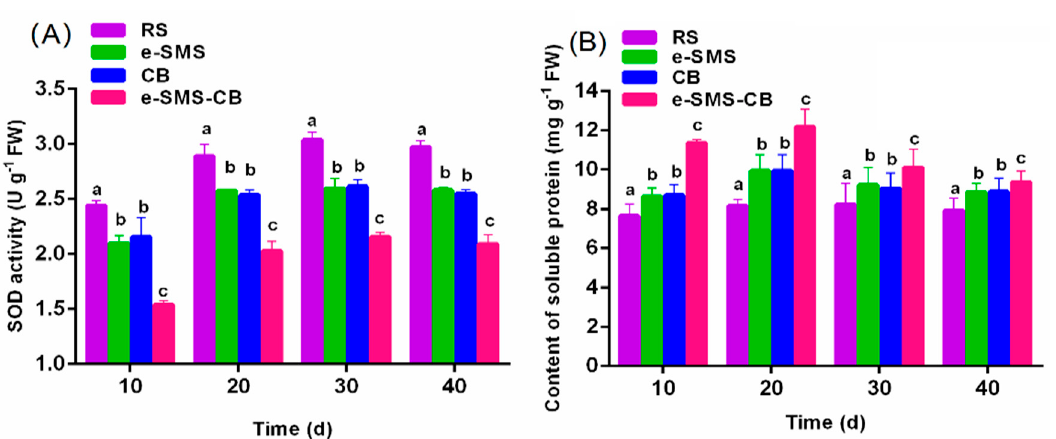
Figure S1. E ff ect of pH-values on chlorimuron-ethyl degradation; Figure S2. E ff ects of culture conditions on the viable counts of the P. eryngiu -SMS-CB and the degradation e ffi ciency; Figure S3. Three-dimensional response surface plot; Figure S4. Scanning electron microscopy (SEM) images; Table S1 Variance analysis for the developed quadratic regression model; Table S2 Number of sequences analyzed, OTUs, estimated community richness estimators (Chao and ACE) and community diversity indices (Shannon and Simpson) of 16S rRNA libraries from the samples.